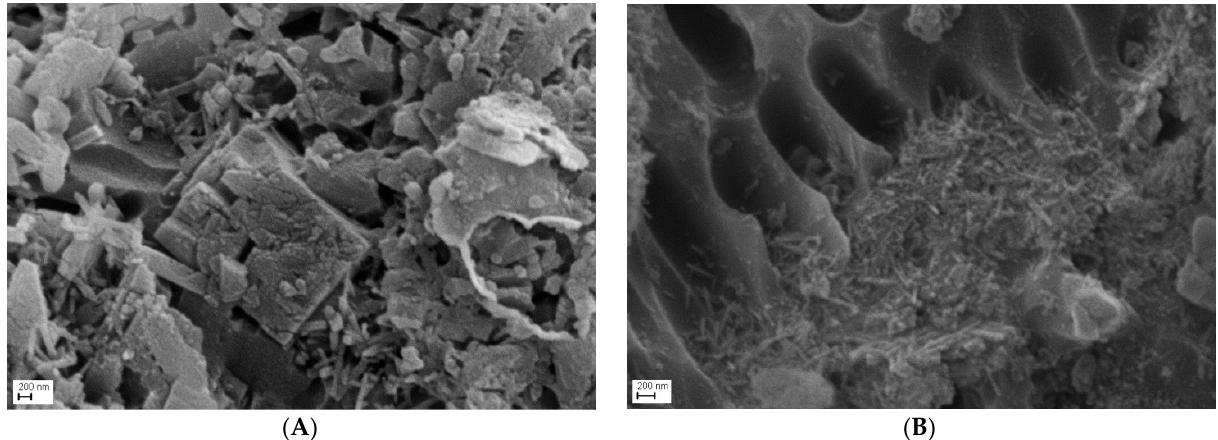
9 Table 3. Quantitative mineralogical compositions (wt%) and crystalline index (%) of 85% HRC and